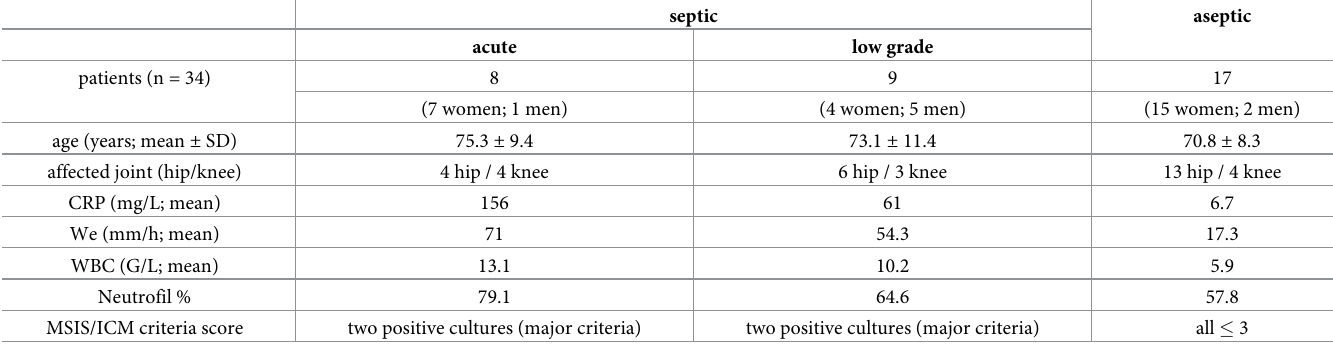
Table 1. Demographic and laboratory data of the involved patients.